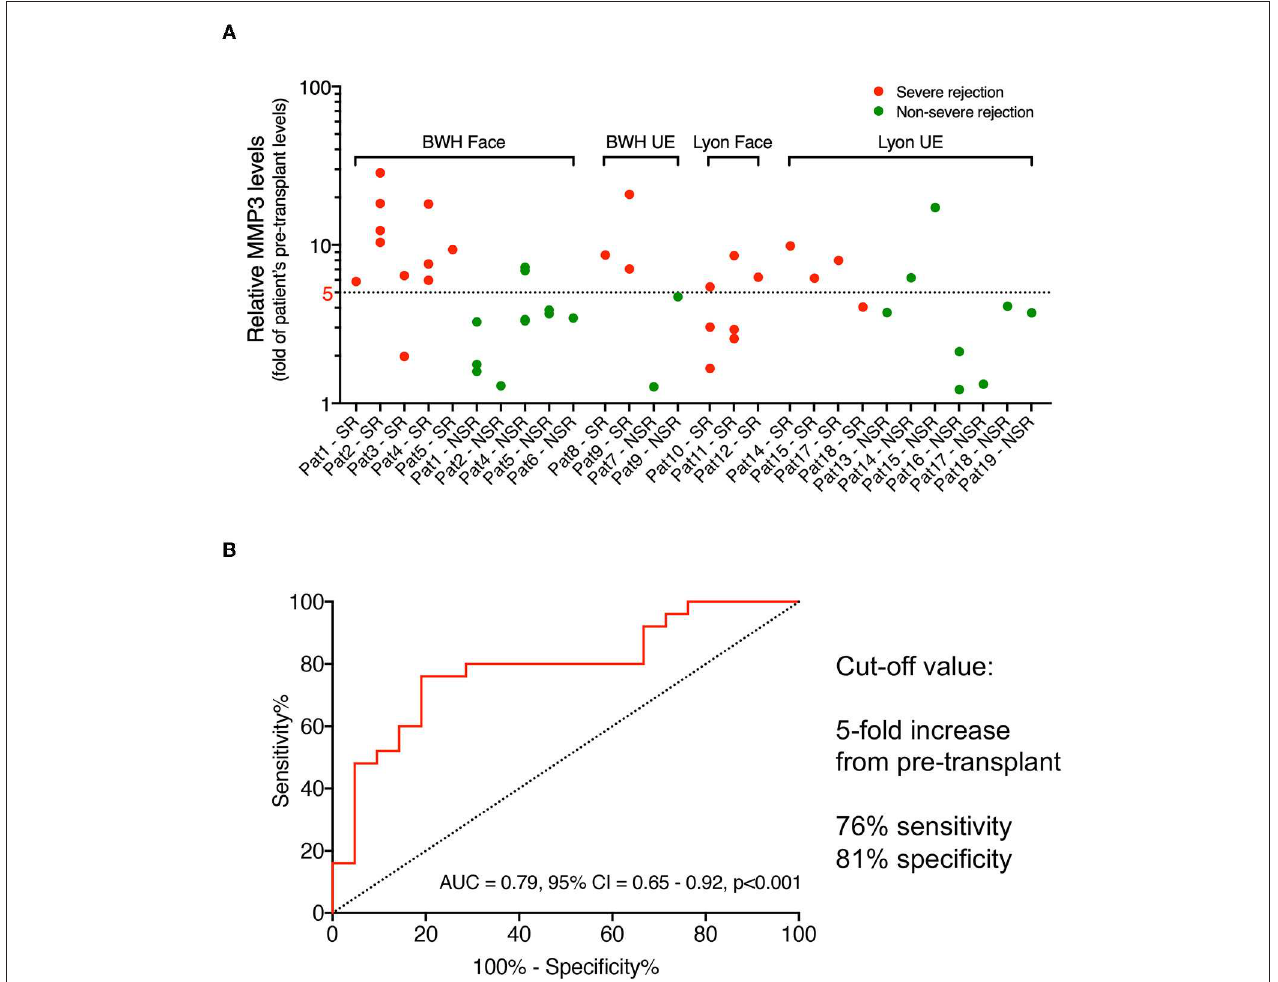
FIGURE 1 | Cut-off values of MMP3 levels to predict treatment response. (A) For all VCA patients (x-axis), the fold-change from each patient’s pre-transplant MMP3 levels (y-axis, logarithmic scale) was calculated for every severe (red dots) and non-severe (green dots) rejection episode. (B) Receiver operating characteristic (ROC) curve (AUC = 0.79, 95% CI: 0.65–0.92, p < 0.001) between severe ( n = 25) and non-severe ( n = 21) rejection episodes determined 5-fold change from pre-transplant levels as optimal cut-off value with 76% sensitivity and 81% specificity. AUC, area under the curve; BWH, Brigham and Women’s Hospital; CI, confidence interval; UE, upper extremity; VCA, vascularized composite